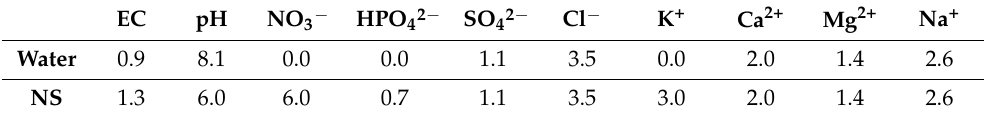
Figure 1. Schematic representation of the experimental setup. Table 2. Chemical composition of the tap water and nutrient solution (NS) after ozone saturation with the values of electrical conductivity (EC) (dS m − 1 ) and macronutrients concentration (mmol L − 1